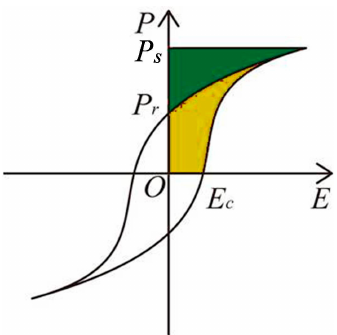
Figure 1. Schematic of a ferroelectric P-E loop. The green area is the discharged energy density W d , while the yellow area is the energy loss of one charge-discharge cycle ( W loss ).